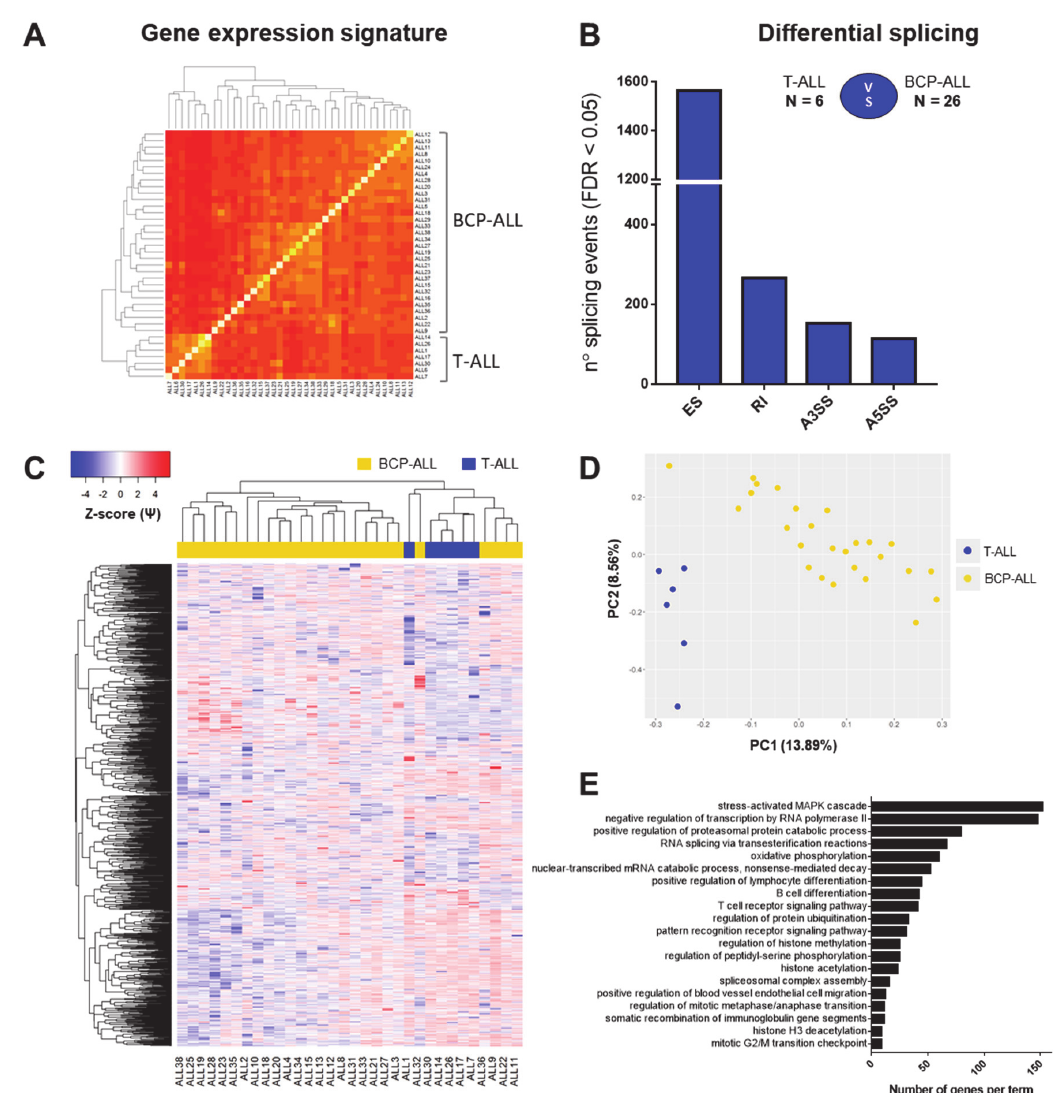
Figure A1. Distinct splicing profiles characterize childhood precursor BCP-ALL and T-ALL. The figure depicts the gene expression profiles and di ff erential splicing analysis comparing 6 T-ALL to 26 BCP-ALL samples. This analysis was performed to evaluate di ff erences in splicing due to the lineage of cells (all T-ALL samples were compared to all BCP-ALL samples). ( A ) Gene expression signature discriminates between BCP and T-ALL (Spearman correlation of gene expression estimates per each sample calculated with EdgeR). ( B ) The number of significant (FDR < 0.05) events per each type (ES—exon skipping, RI—intron retention, A3SS—alternative 3’ splice site, A5SS—alternative 5’ splice site). ( C ) Hierarchical clustering performed using all significant differential splicing events. Inclusion levels (or Percentage Spliced-In, Ψ ) per each event were generated by rMATS, Z-score-normalized and plotted as a heatmap. The colored bar over the heatmap represents the subtype of ALL (yellow—BCP-ALL, blue—T-ALL). ( D ) PCA plot created by using Ψ values for all significant di ff erential splicing events. ( E ) Top 20 major GO terms with the largest numbers of genes in the dataset. GO search was performed in ClueGO (Cytoscape plugin) using all genes a ff ected by significant di ff erential splicing